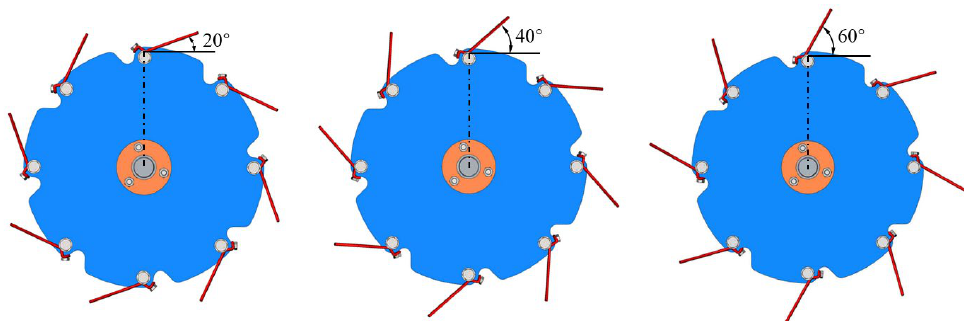
Figure 5. Schematic diagram of different installation inclination angles.